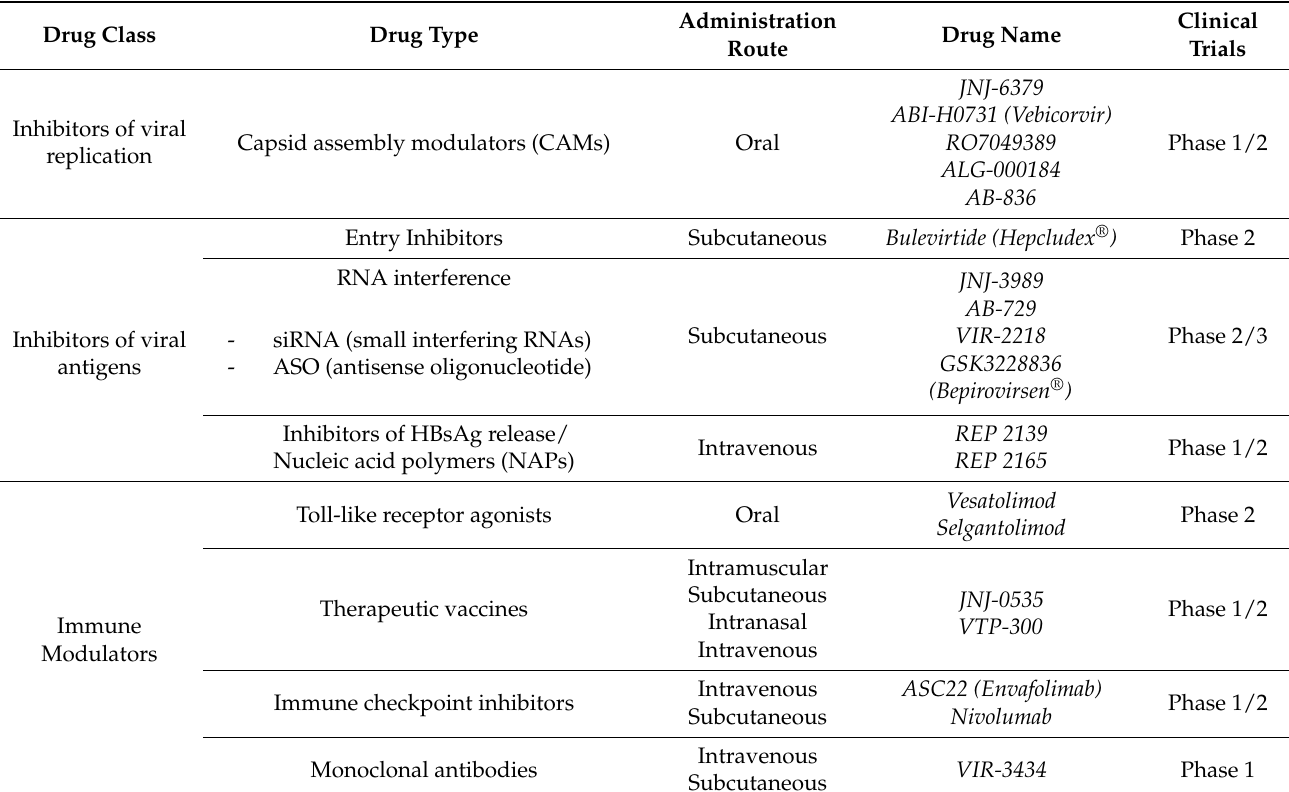
Table 1. Overview of new HBV compounds under